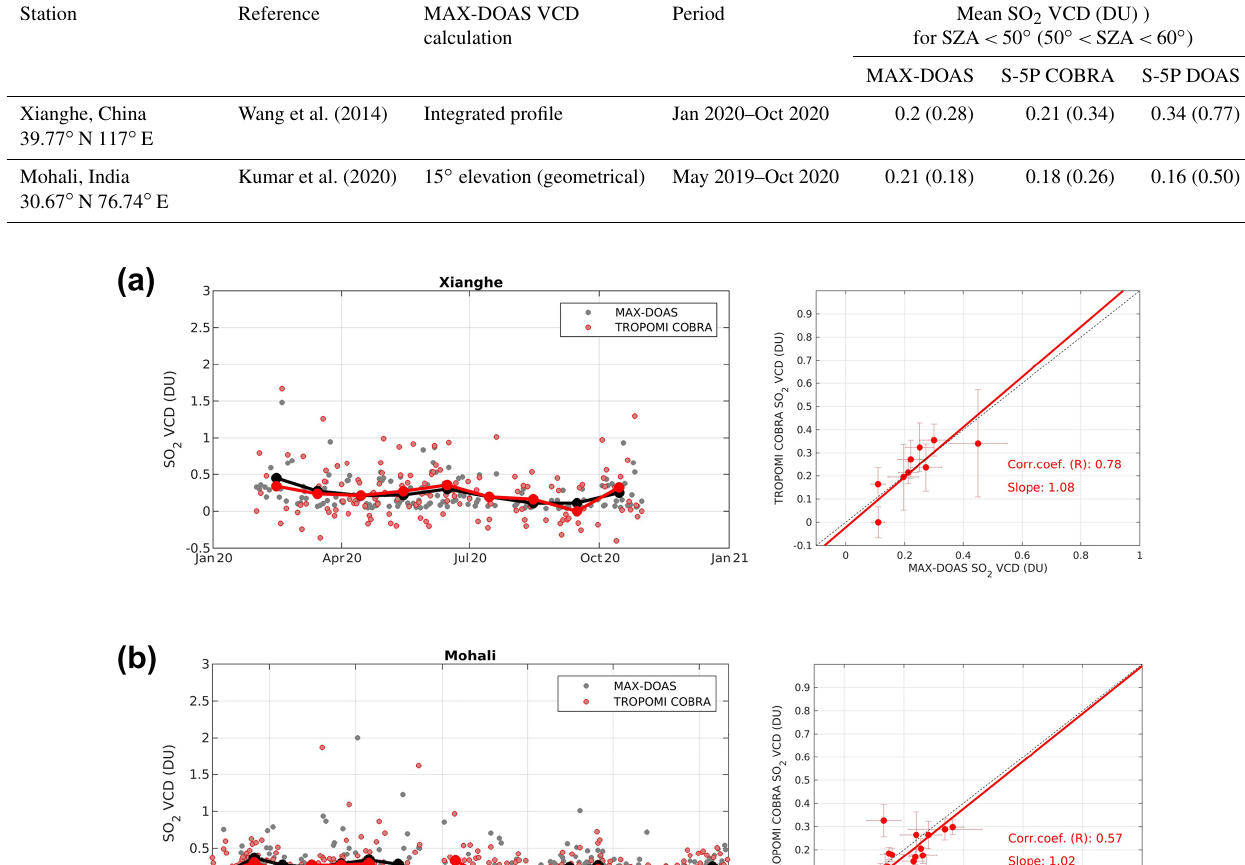
Table 1. Summary of SO 2 VCD comparison.